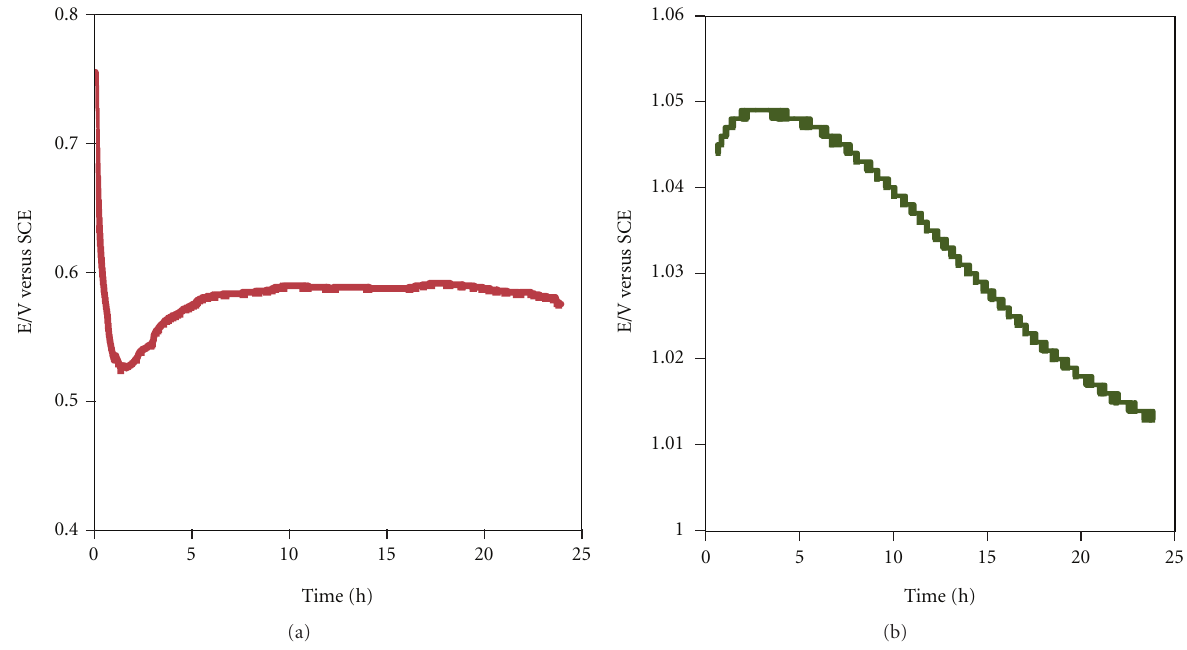
Figure 6: Open-circuit potential evaluation of the biomass suspension in presence of (a) Ag ions and (b) Au ions.